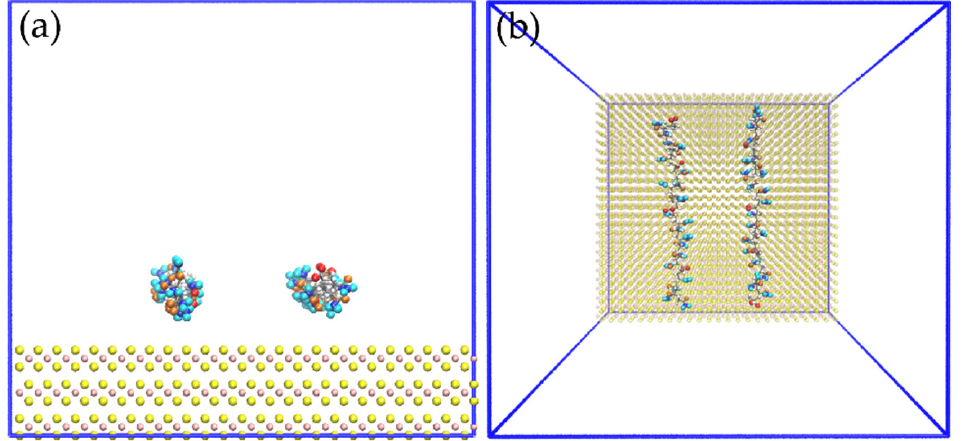
Figure 8. Snapshots of initial configuration for simulation of two molecules of HPAM over the molybdenite face; ( a ) side view and ( b ) top view.